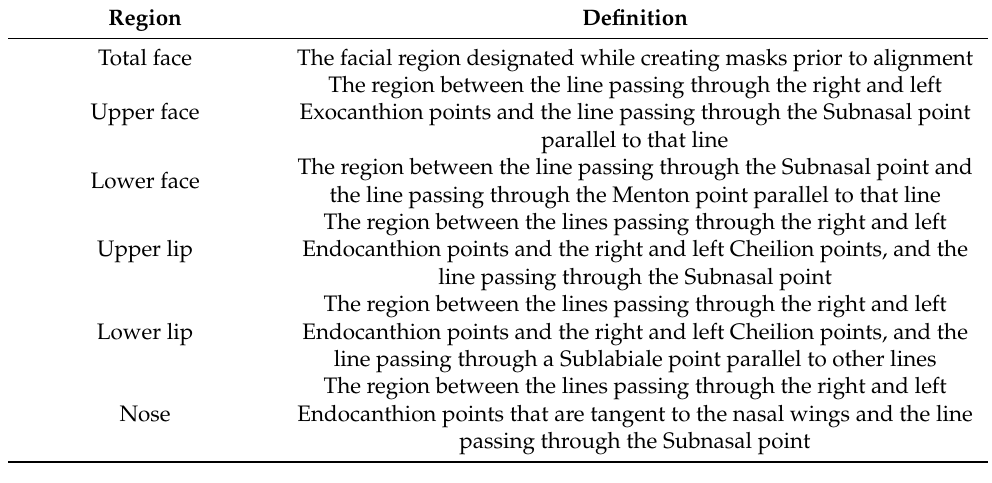
Table 2. Definition of morphological regions used for the 3D deviation analyses.